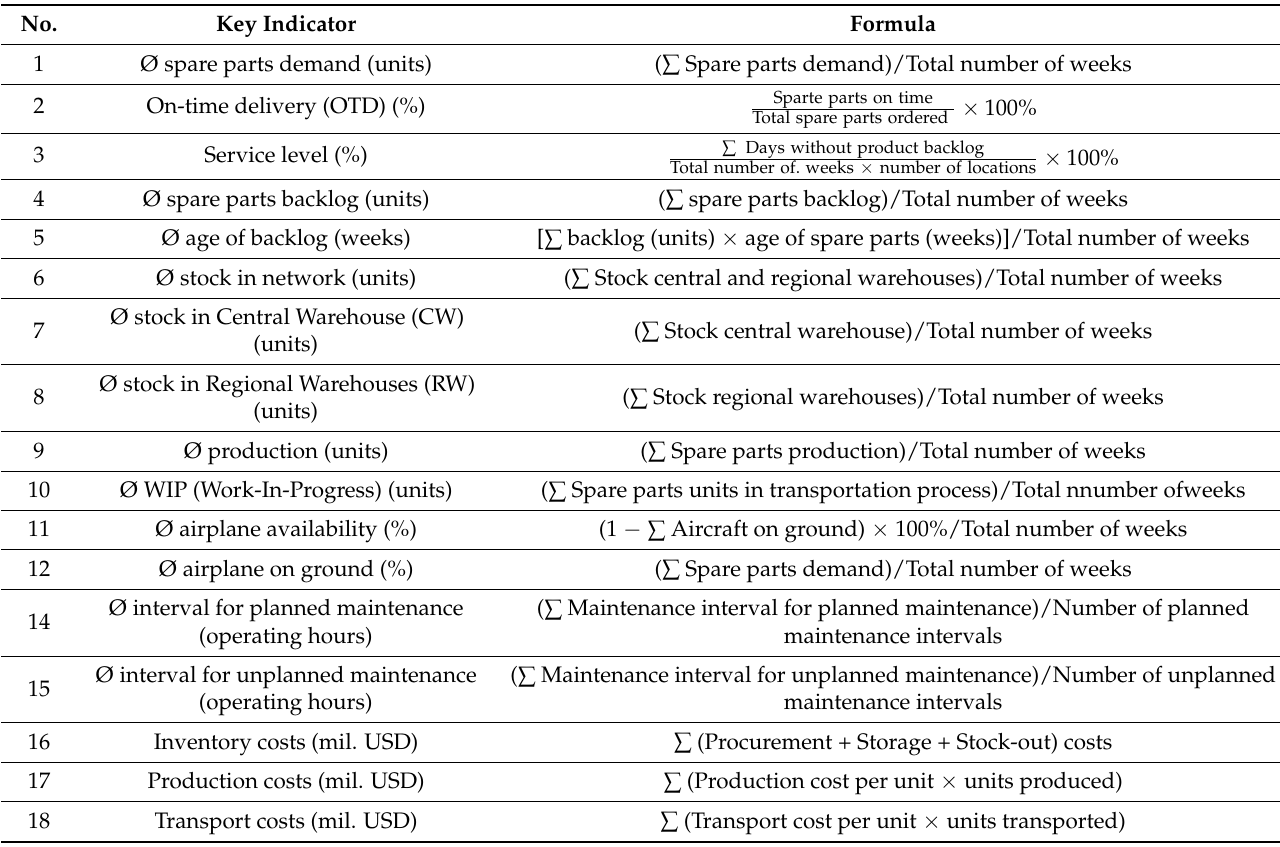
Table 1. Key performance indicators (KPIs) for the target system (own